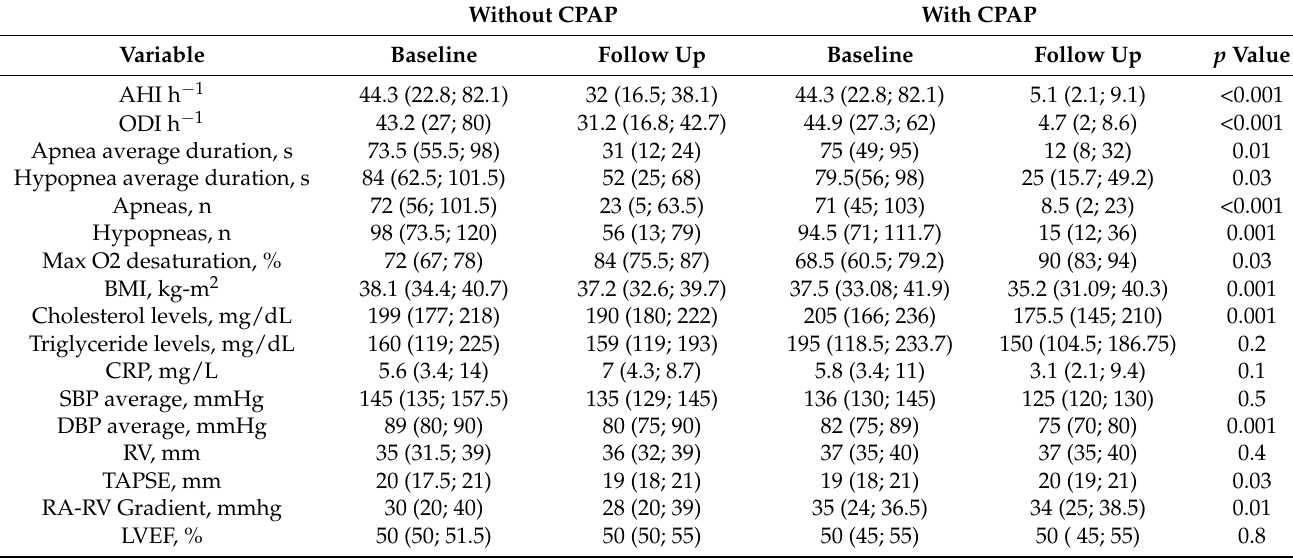
Table 2. Effect of Continuous Positive Airway Pressure Treatment on the evolution of studied